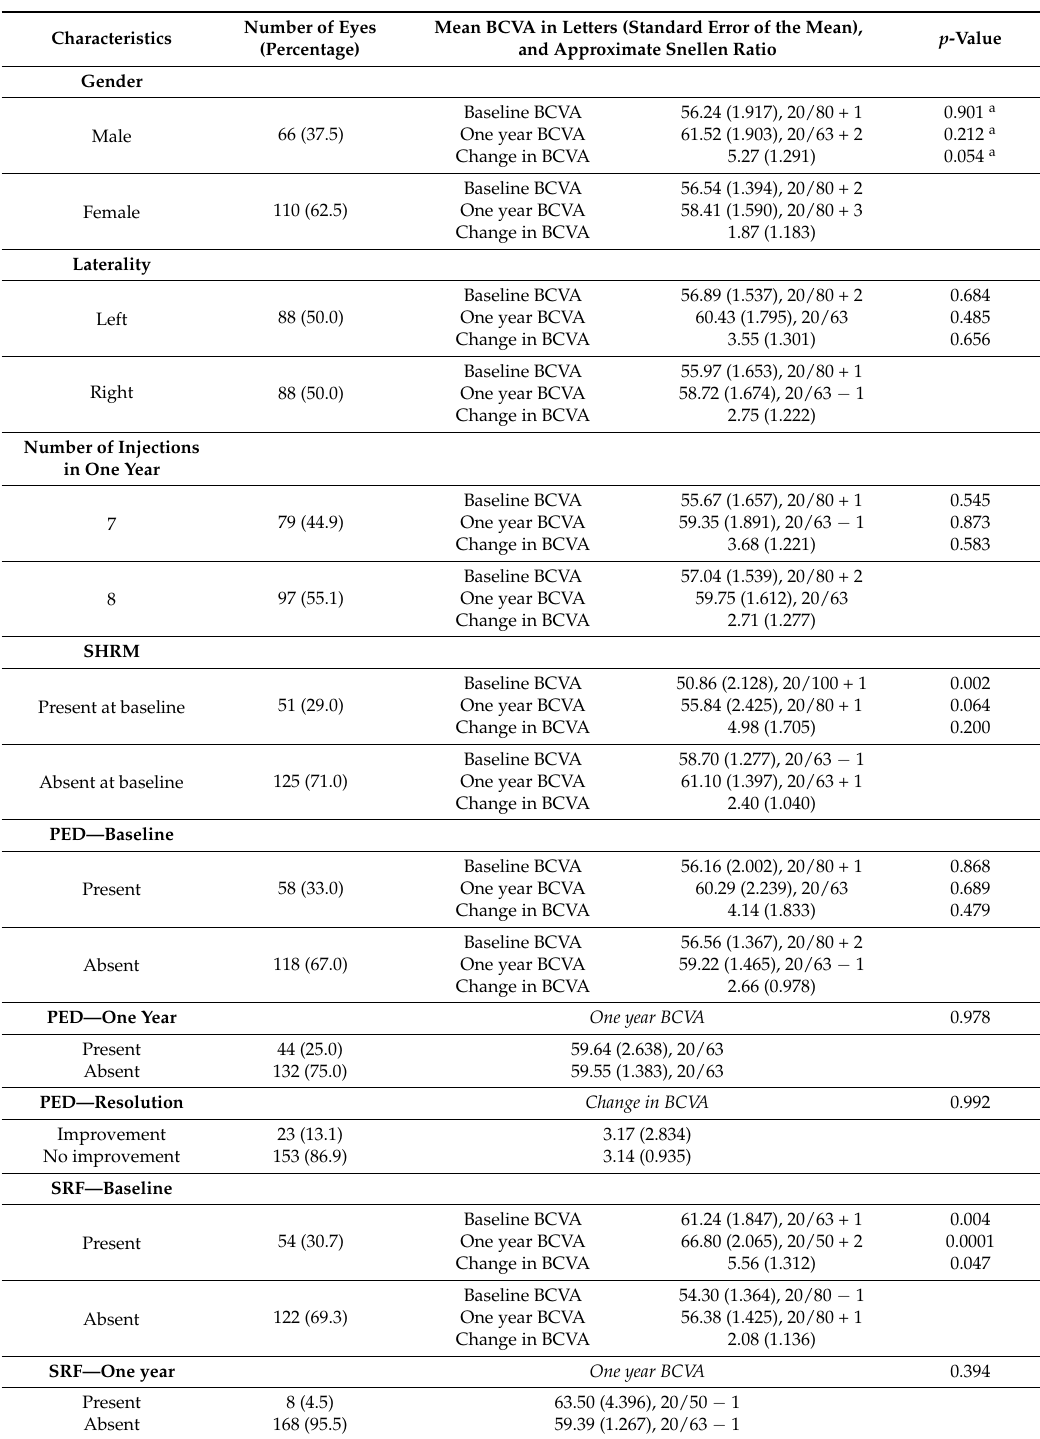
Table 1. Characteristics of the eyes included in this study and their frequencies of